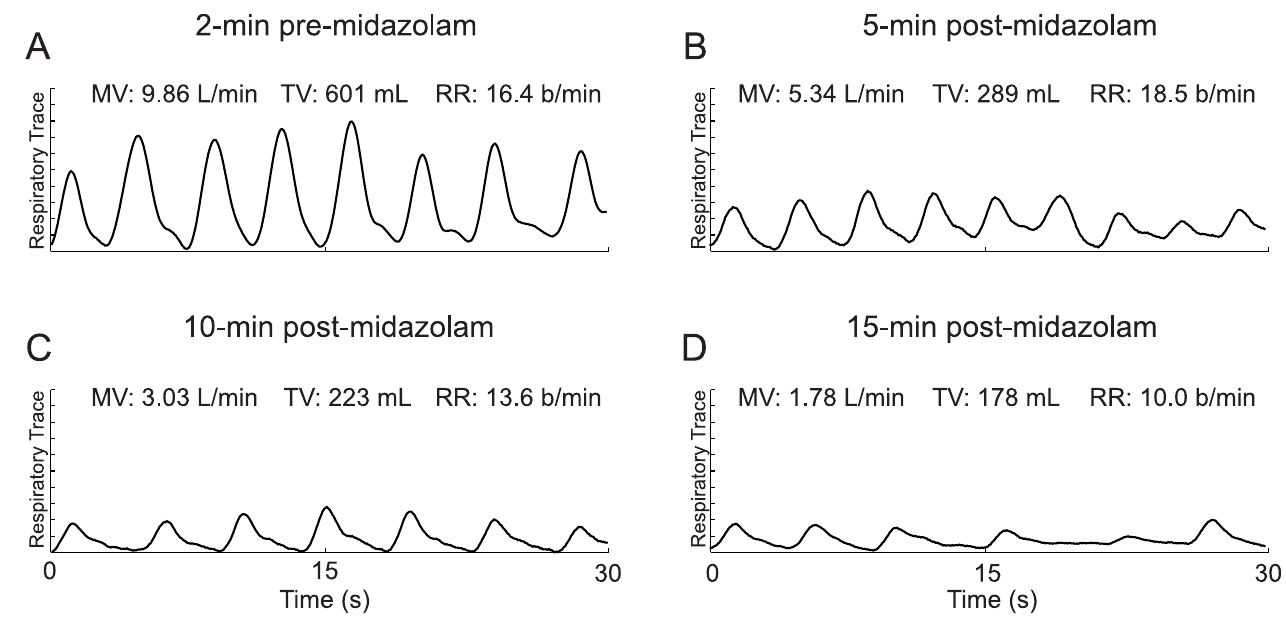
Fig 2. Thirty-second snapshots of RVM traces from a 66 y/o male patient (165 cm, 78 kg, BMI: 29 kg/m 2 ) undergoing a left hip replacement surgery. These traces show a clear and immediatedecreasein both MV and TV followingmidazolamadministration, coupledwith marginaland delayeddecreasein RR. ( A ) Pre-midazolam values (2 min pre-dose)were taken as baseline.( B ) Within 5 min of the dose, breathing was notablydepressedwith MV and TV effectively decreased by half, while RR marginally increased. ( C ) Ten minutes post-midazolam, MV and TV had decreased from pre-dosevalues by 69.3% and 62.9% respectively(MV: 9.9 to 3.0 L/min; TV 600 to 220 ml) while RR only decreasedby 17.9% (16.4 to 13.6 b/min). ( D ) At 15 minutes post-midazolam, MV and TV had further decreased from pre-dosevalues by 81.9% and 70.4%, respectively(MV: 9.9 to 1.8L/min; TV: 600 to 180ml). RR finally shows a substantialdecreaseof 39.0% (RR: 16.4 to 10.0 breaths per